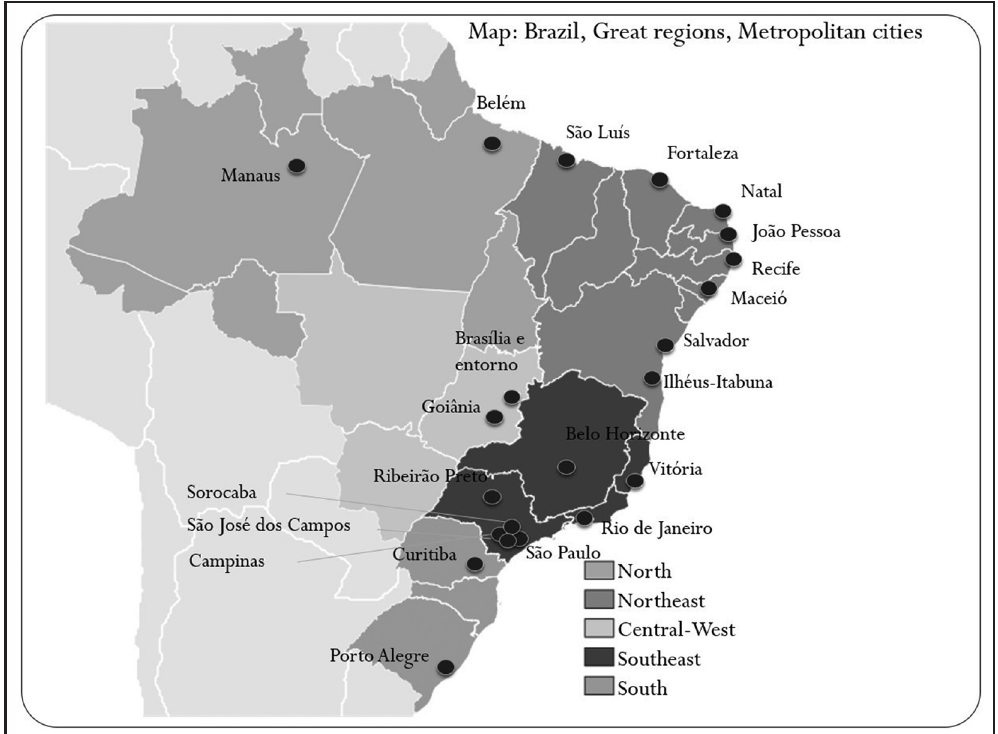
Figure 1 Map of greater regions and metropolitan cities of Brazil.